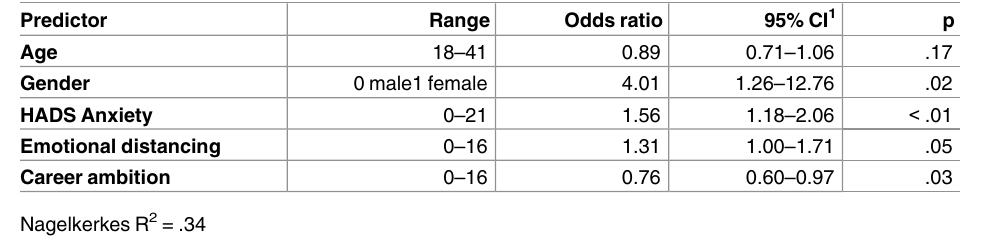
Table 3. Predictors of